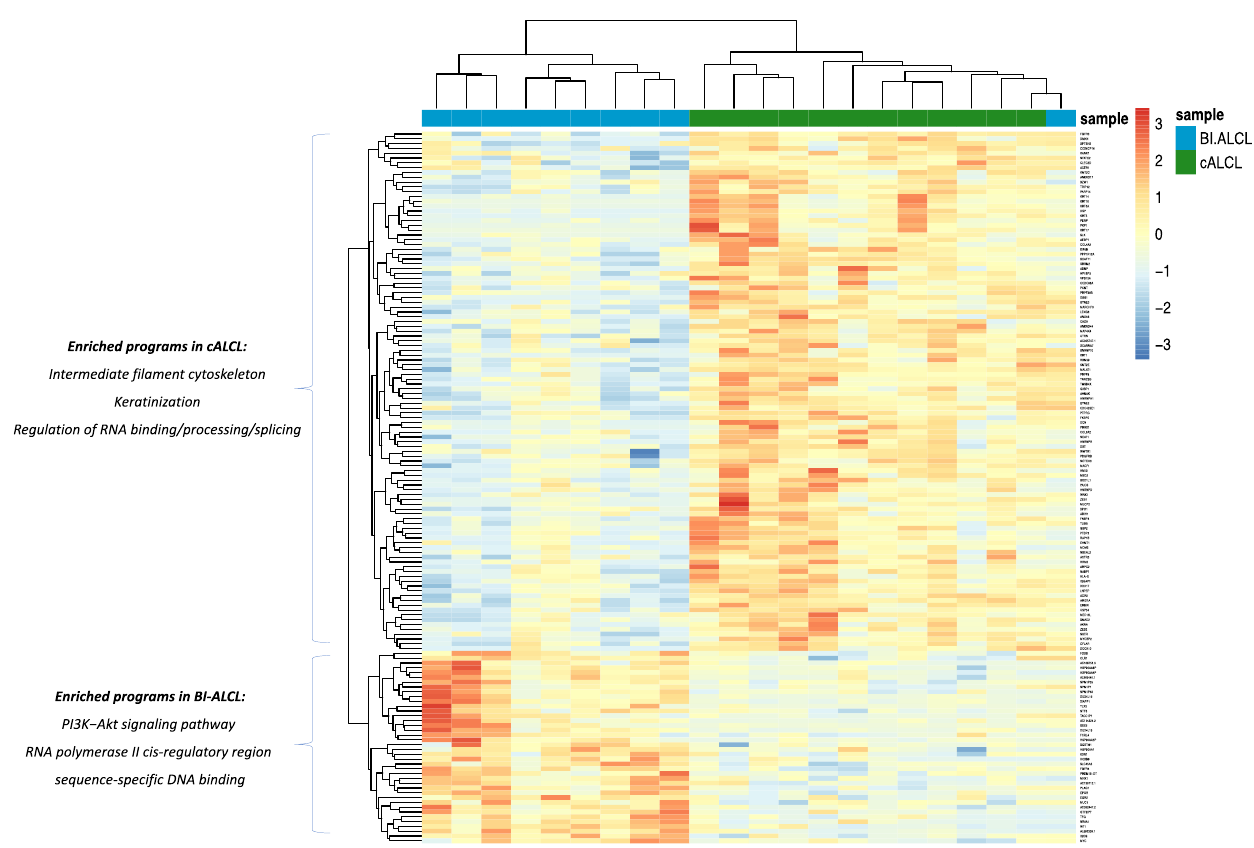
(40 genes upregulated in BI-ALCLs and 108 upregulated in cALCLs) that neatly separated BI-ALCLs and cALCLs (Figure 4, Table S2), WT1 was among the top-10 upregulated DEGs in BI-ALCLs ( p = 9.1 × 10 − 5 , fold change 4.78). To validate this at the protein level, we immunostained eight BI-ALCL, four cALCL and two ALK+ sALCL samples for WT1. In all eight BI-ALCLs, most of the tumor cells showed nuclear and occasional cytoplasmic staining, whereas the cALCL and ALK+ sALCL samples were negative (Figure 5).